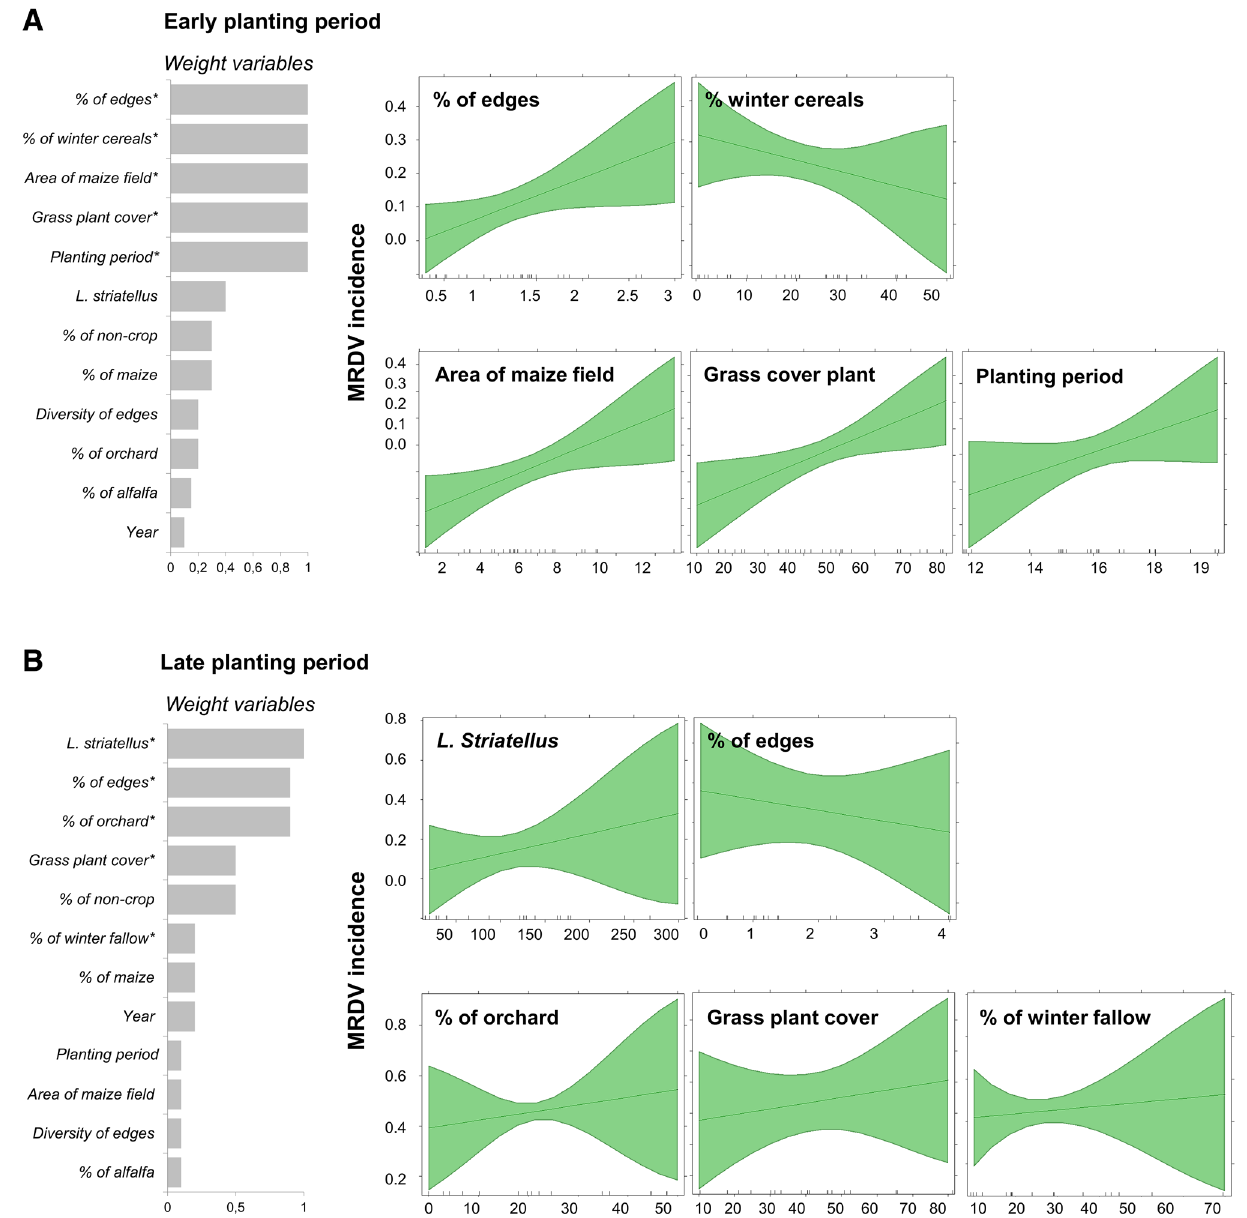
Figure 1. Effects of field and landscape variables on MRDV incidence on early and late planting periods. Generalized linear models (GLMs) using a binomial distribution were used in the model average and multi- model inference to select the best predictor model for MRDV incidence. The grey bars show the relative importance of each predictor variable (i.e., the sum of Akaike weights of the models in which each variable is optimized following the criterion ΔAIC < 2). The green graphs show the effects of significant variables (*) on MRDV models and how they varied depending on the planting period represented by the confidence intervals that contain a wide range of MRDV incidences. Therefore, the differences in incidence caused the interval widths to vary, and this effect was stronger in the late planting